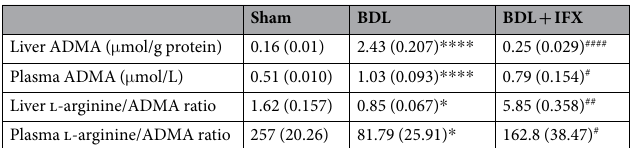
Sham BDL BDL + IFX Liver ADMA ( μ mol/g protein) 0.16 (0.01)